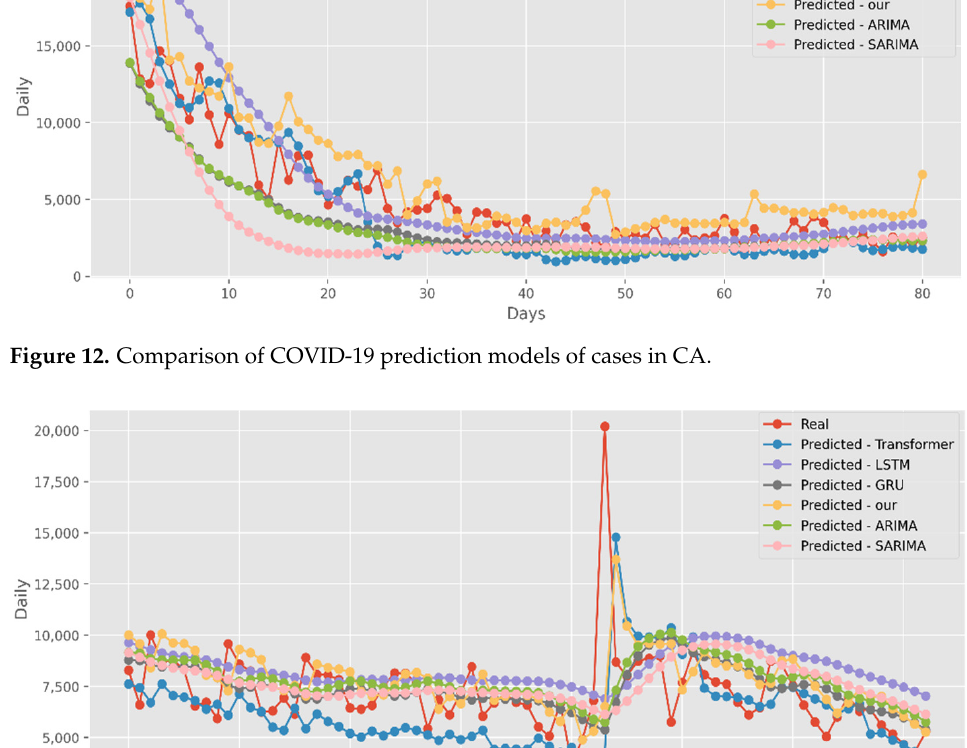
Figure 14. Comparison of COVID ‐ 19 prediction models of cases in VA. 5.3. Forecasting the Number of Deaths Similar to the analysis above, our model fits well with a variety of data sets, fully displaying its great predictive ability. The predictions of four DL algorithms and two tra ‐ ditional models are contrasted with the test dataset of actual deaths in Figure 15. This graph’s y ‐ axis shows how many people die in California each day. The final two months of 2021, March and April, are represented by the x ‐ axis. Additionally, Figure 16 compares the four DL algorithms and two traditional models by projecting date ranges using the test dataset from New York. The daily death toll in New York is shown on the y ‐ axis. Figure 17 compares four DL algorithms and two traditional models by forecasting using the date ranges from the VA test dataset. The total number of VA fatalities is shown on